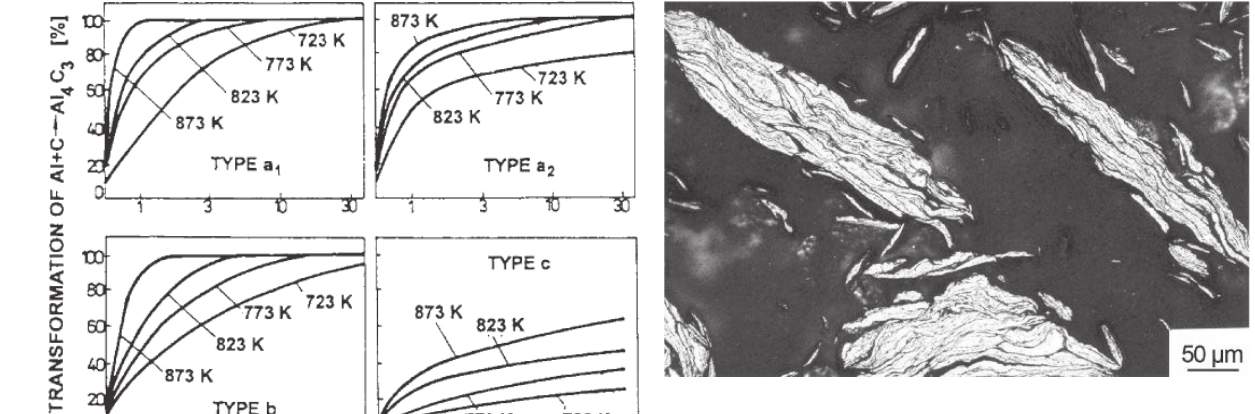
Fig. 4: Granules after 30 min milling – welding process, Al + 1C material